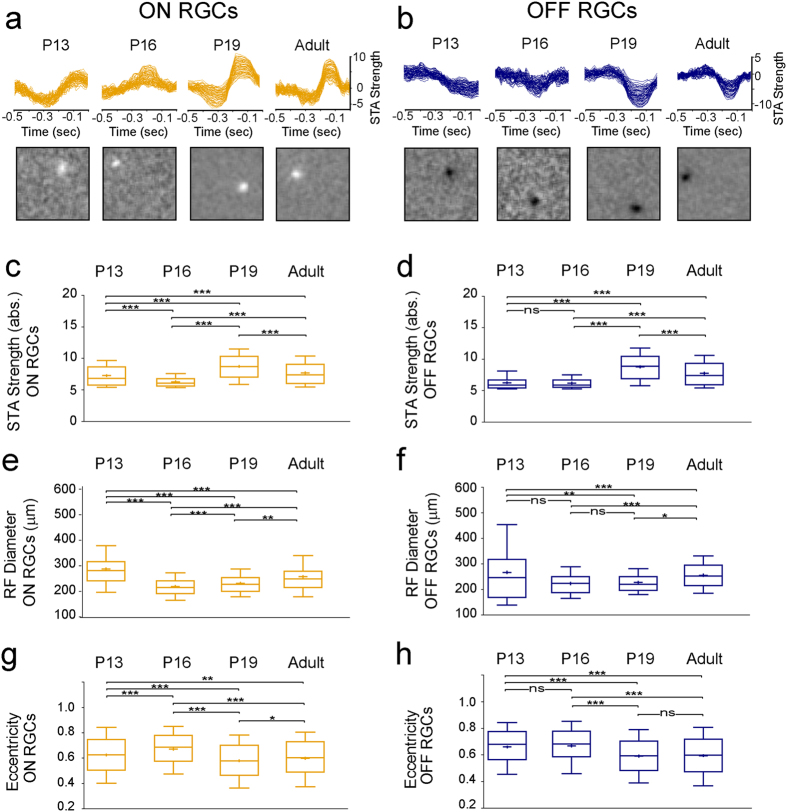
Shifted White Noise used to study the development of RGC RF central areas.(a,b) STA signal strength (top) and spatial profiles (bottom) for selected example RF central areas from ON (a) and OFF (c) RGCs from all 4 age groups (see below). (c–h) Box plots (whiskers: 10–90 percentile, mean indicated by + symbol) of ON (yellow boxes; P13-N = 2 retinas, n = 449 cells; P16-N = 2, n = 425; P19-N = 2, n = 926; adult-N = 2; n = 698) and OFF (blue boxes; P13-N = 2, n = 309; P16-N = 2, n = 239; P19-N = 2, n = 794; adult-N = 2, n = 514) RGC responses from all retinal areas for STA signal strength (c,d), RF diameters (e,f), and RF eccentricity (g,h). Significance: *p < 0.05; **p < 0.01; ***p < 0.001; ns = not significant. Detailed p-values can be found in Supplemental Table S13.